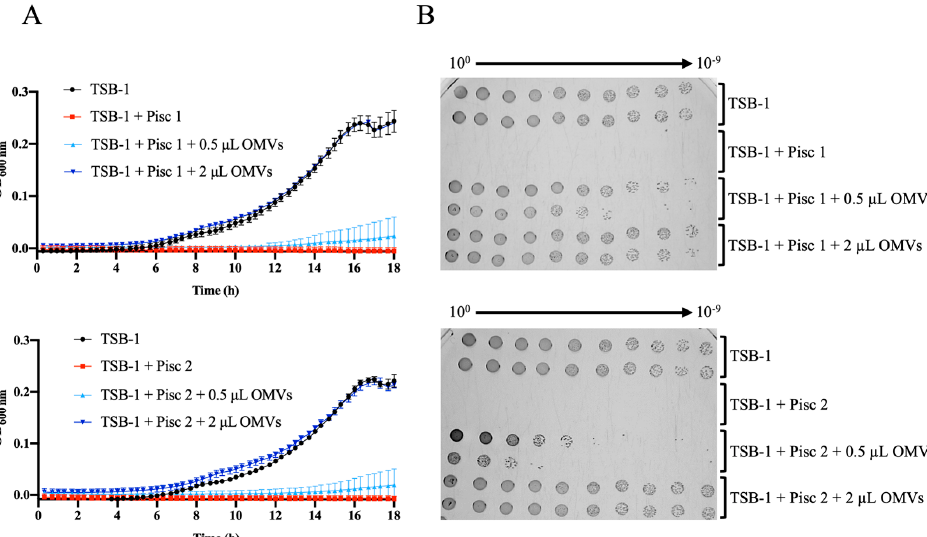
Figure 5. OMVs protect Phdp from the microbicidal activity of sea bass antimicrobial peptides. Phdp MT1415 was inoculated in TSB-1 (control) or in TSB-1 containing 7.4 or 9.1 μ M of sea bass piscidin 1 (Pisc 1) or piscidin 2 (Pisc 2), respectively, supplemented or not with 0.5 or 2 μ L of MT1415 crude OMVs, corresponding to a supplementation with 5.9 × 10 13 or 2.4 × 10 14 vesicles/mL. Bacterial growth was analyzed by measuring the OD 600nm overtime ( A ) and by plating serial 10-fold dilutions of the cultures on TSA-1 plates ( B ). Results shown are representative of three independent experiments.